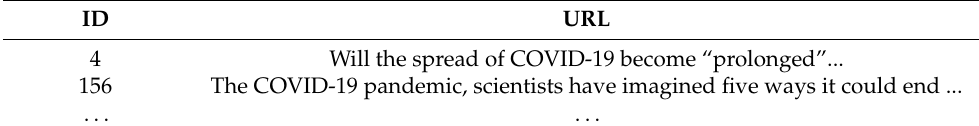
Table 4. Partial text information of effective epidemic information. ID